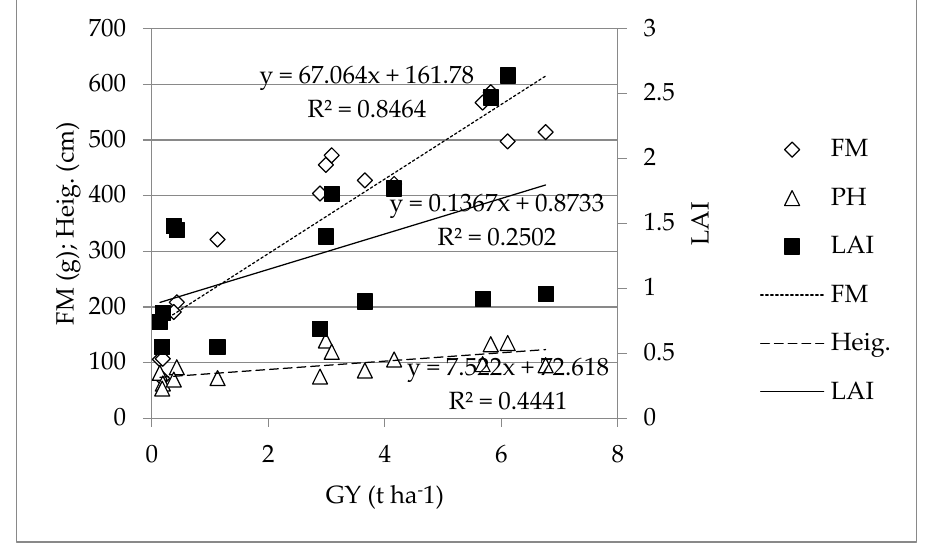
Figure 6. Correlation between grain yield (GY) and fresh matter (FM), plant height (Heig.) and leaf area index (LAI) 21 DAT when FP fertilizer was applied.